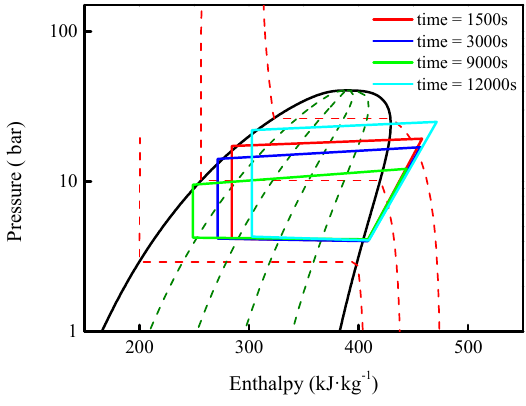
Figure 18. p-h diagrams of VCR in thermal management in a hot day.